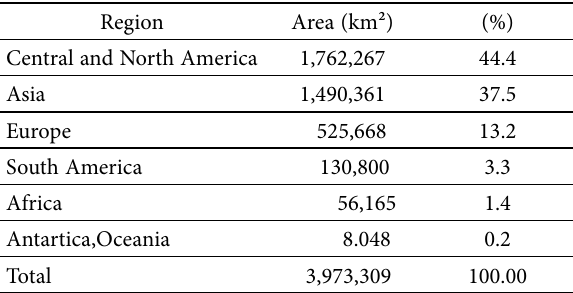
Table 1. Global peatland area by region (World Energy Council 2013) Region Area (km²) Central and North